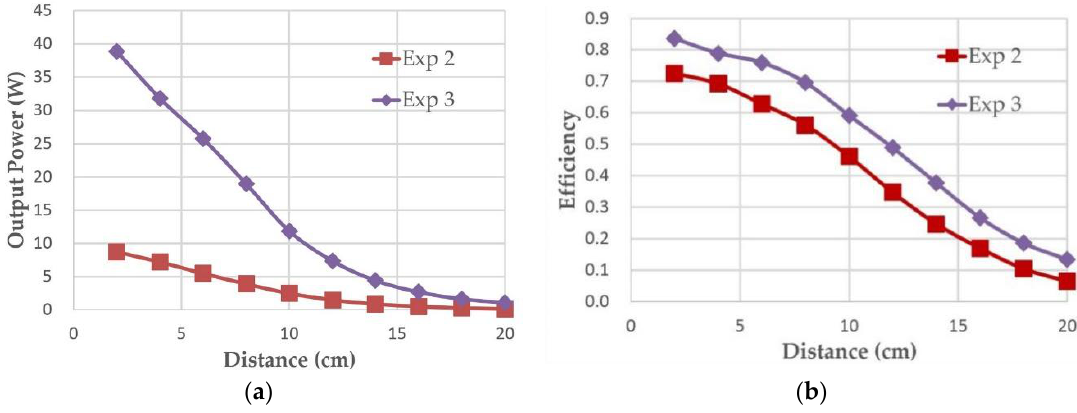
Figure 13. Comparison of Exp 1 and Exp 2 versus distance: ( a ) output power; ( b ) system efficiency.